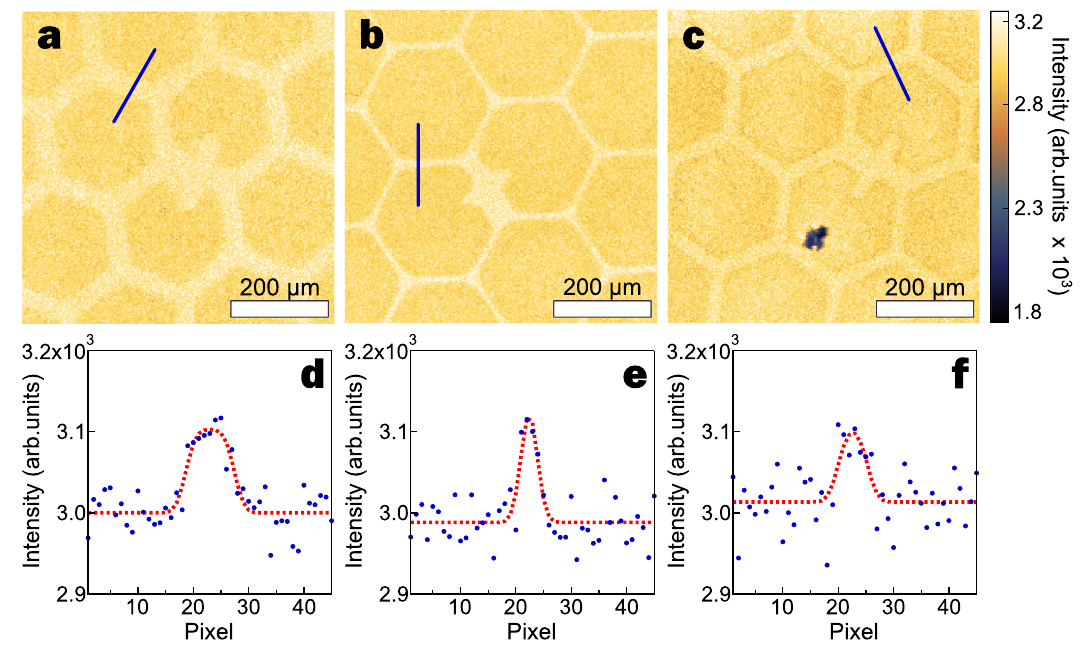
Fig.1|Patternedgold fi lmsonsiliconsubstrate. SHeMmicrographsofthermally evaporated gold fi lms of thickness a 9±1; b 80±8; and c 778±78Å.The substrate was masked by a TEM grid, resulting in unaffected silicon (bright pattern) and the gold fi lm (darker regions). The dark spot in c is a dust particle, exhibiting supra- resolution topographic contrast. A different TEM grid batch was used for micro- graph b .Allmicrographsusethesameintensityrange(seecolorbar)toallowdirect